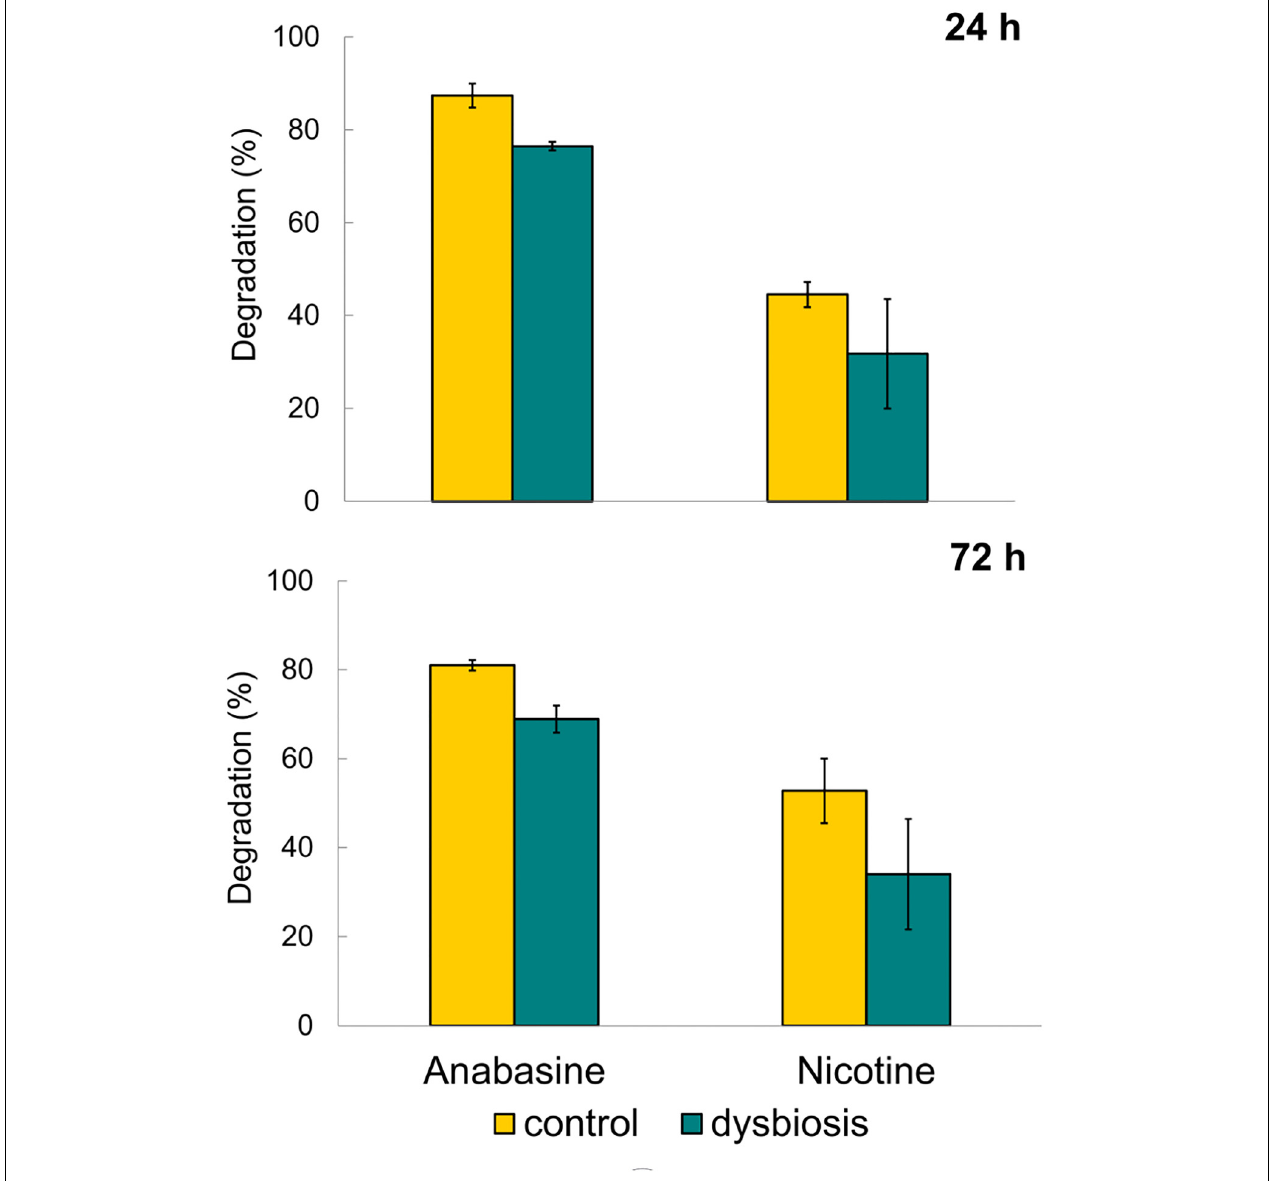
FIGURE 2 | Degradation of anabasine and nicotine after 24 and 72 h of treatment with alkaloids and alkaloids + antibacterial agents. n = 3 birds in each of the four treatments (see also Figure 1 ). Results are presented as mean ±